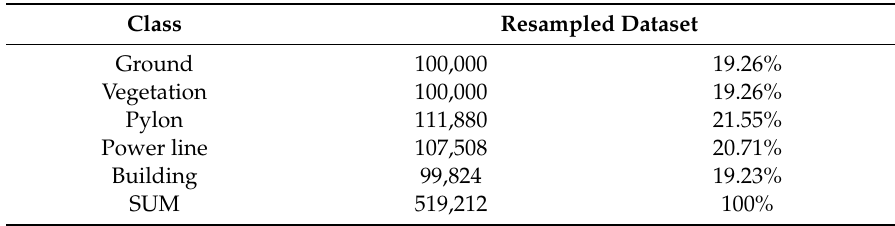
Table 9. The resampled training dataset. Table shows the number of points and proportion per class after